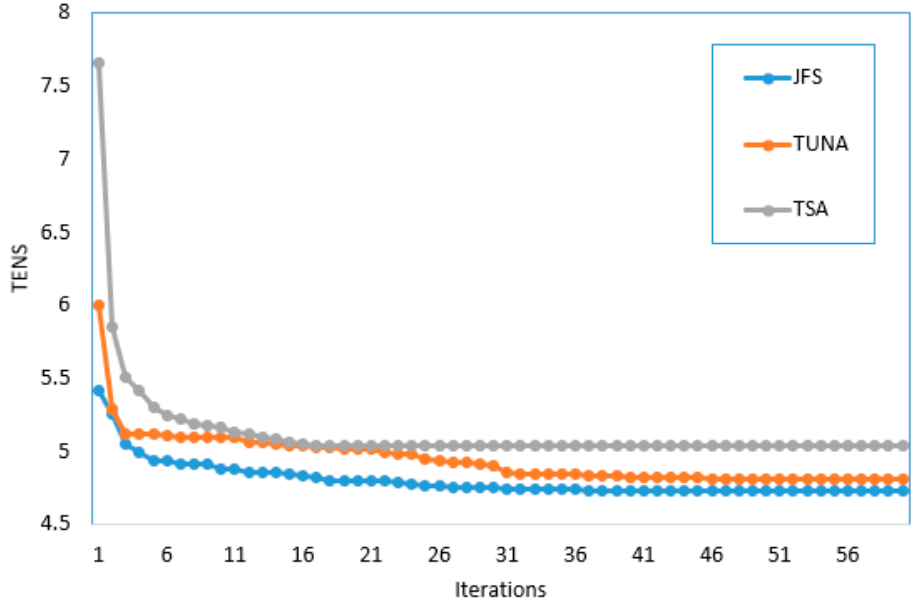
Figure 5. Convergence curves of TUNA, TSA and JFS algorithms for case 3.